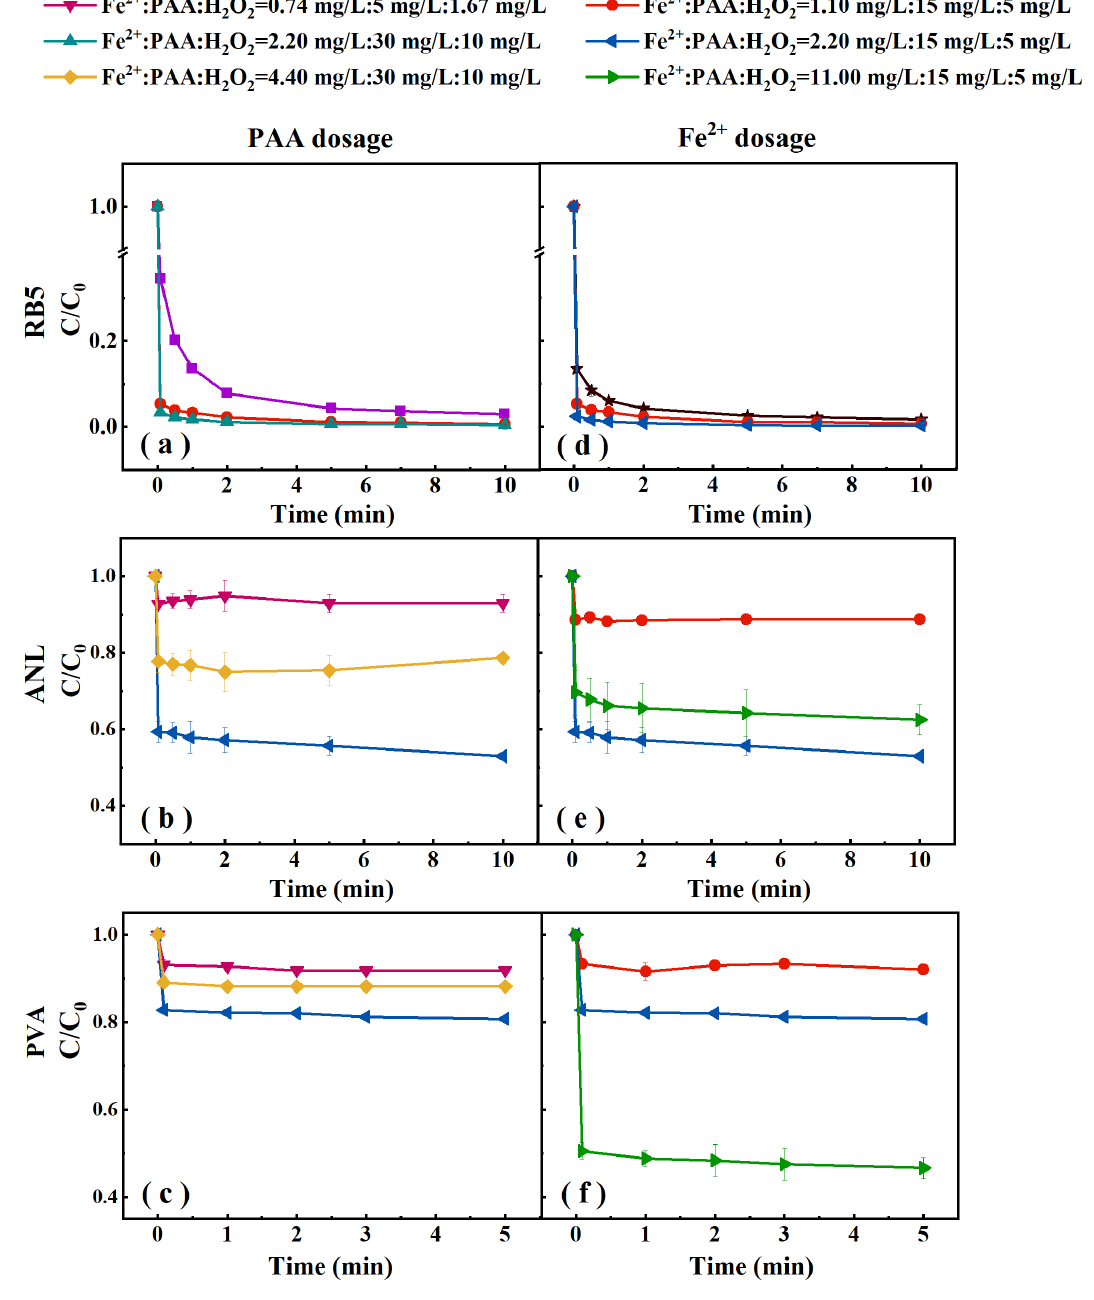
Figure 2. Effects of PAA and Fe 2+ dosages on the degradation of ( a , d ) RB5, ( b , e ) ANL and ( c , f ) PVA. Conditions: [RB5] 0 = 20 mg/L, [PVA] 0 and [ANL] 0 = 10 mg/L, initial pH = 3.0, T = 21 ± 1 °C.